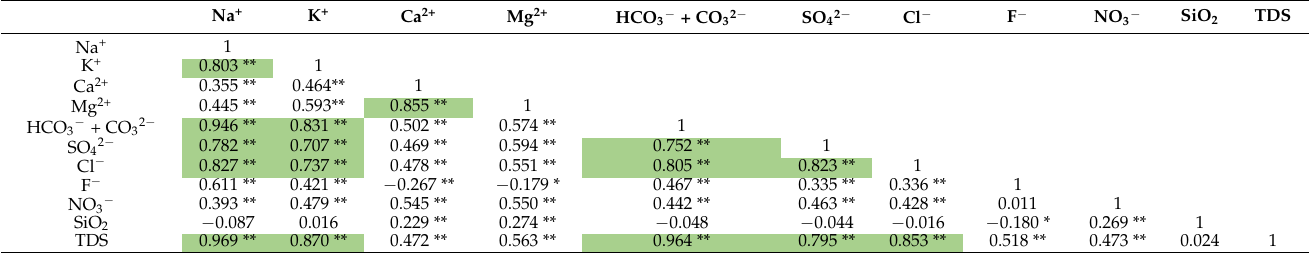
Table 4. Correlation matrix for all water samples (n = 181). Strong correlations are highlighted in green colour. Na + K + Ca